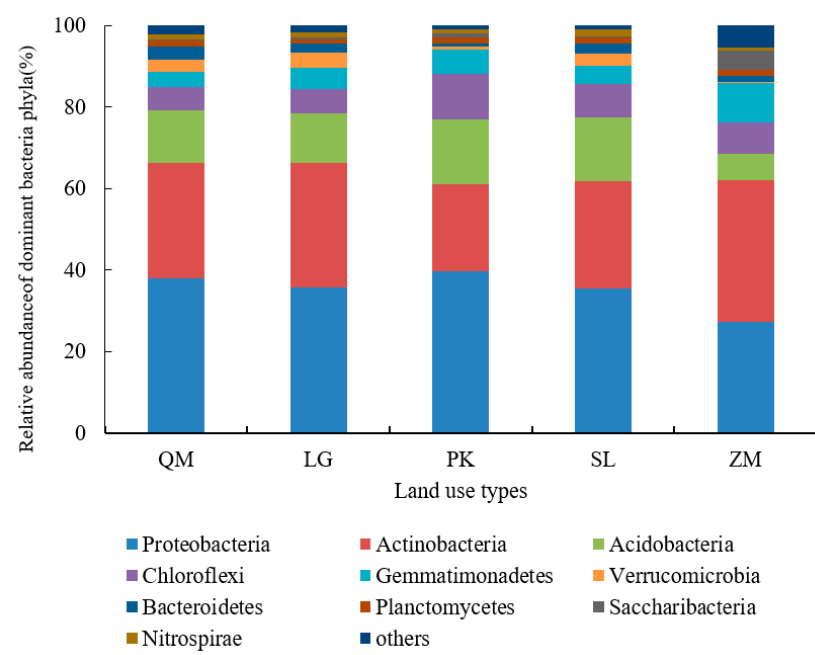
Figure 2. Relative abundance of soil bacteria at the phylum level from soils with different land use types. Relative abundances are based on the proportional frequencies of bacterial DNA sequences that could be defined at the phylum level. QM; Quercus mongolica ; LG: Larix gmelinii ; PK: Pinus koraiensis ; SL: Shrubland; ZM: Zea mays .